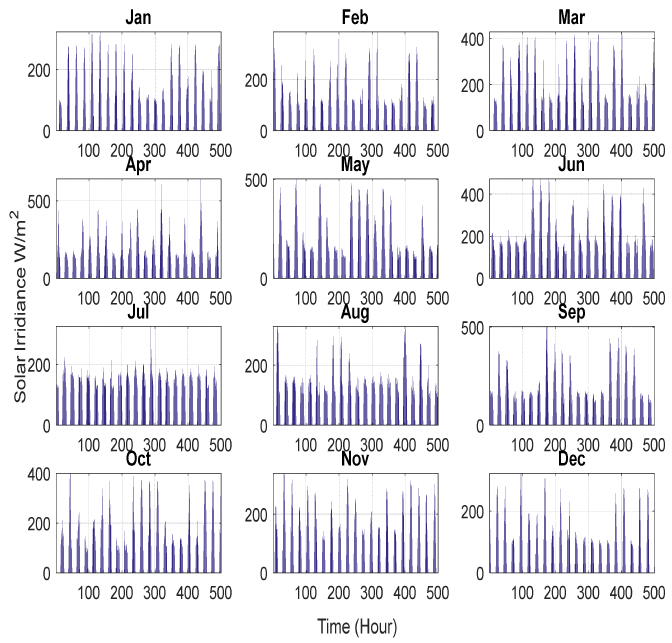
Figure 3. Monthly solar irradiance data for the case